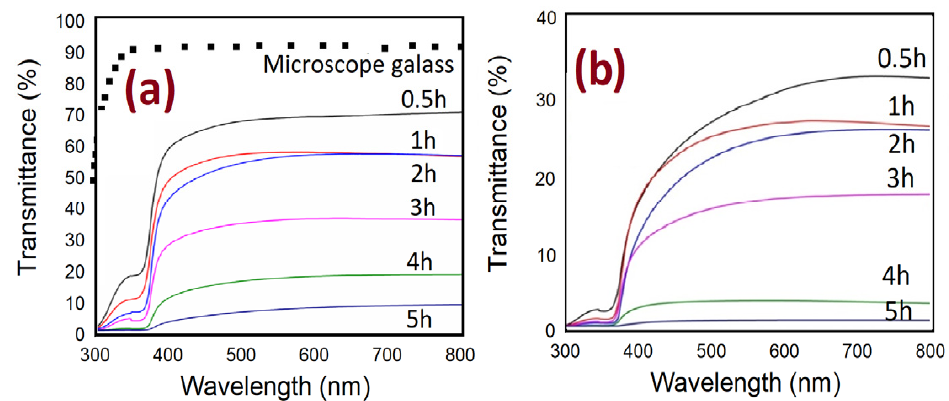
Figure 14. Optical transmittance spectrums of ZnO nanorods fabricated at different growth durations for both methods of preparation: ( a ) conventional CBD and ( b ) modified CBD.